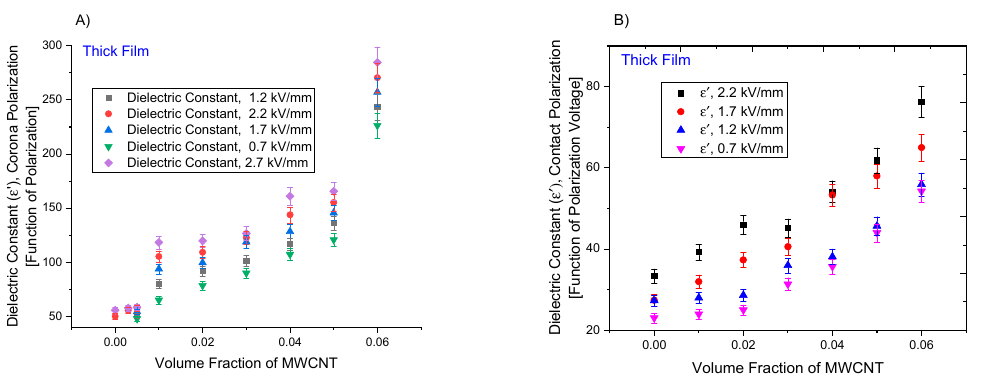
Figure 8. Dielectric constant of thick films as a function of polarization voltage and volume fraction of MWCNTs for ( A ) corona and ( B ) contact polarization conditions.